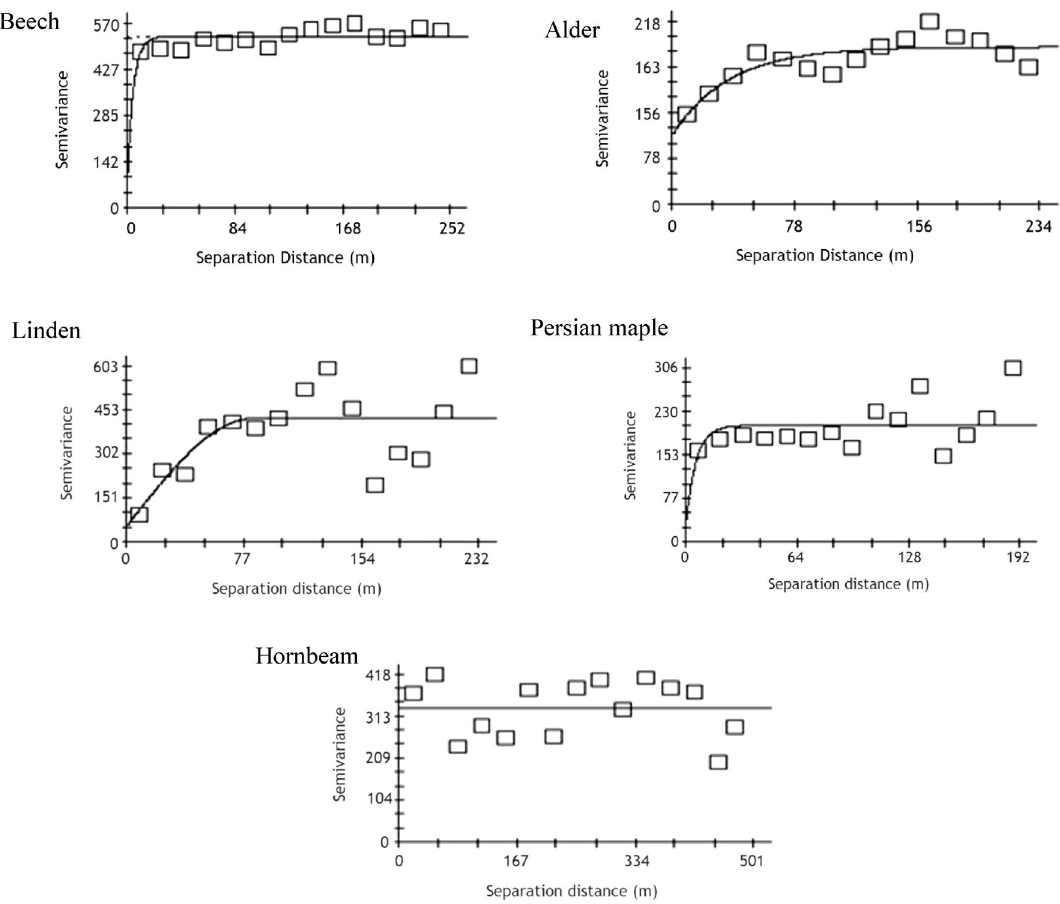
Figure 7. Experimental variogram and the estimated linear model for beech ( Fagus orientalis ), alder ( Alnus subcordata ), linden ( Tilia platyphyllos ), Persian maple ( Acer velutinum ) and hornbeam ( Carpinus betulus